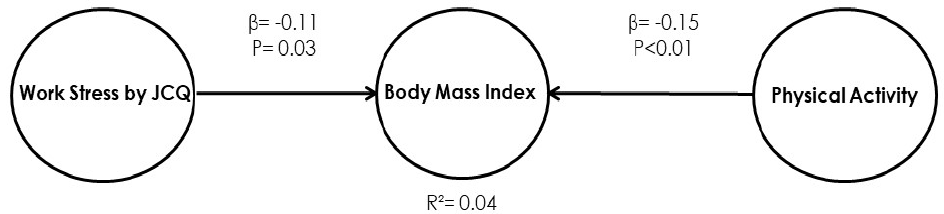
Figure 5. Model 3. Relationships between physical activity, job content (work stress by JCQ), and